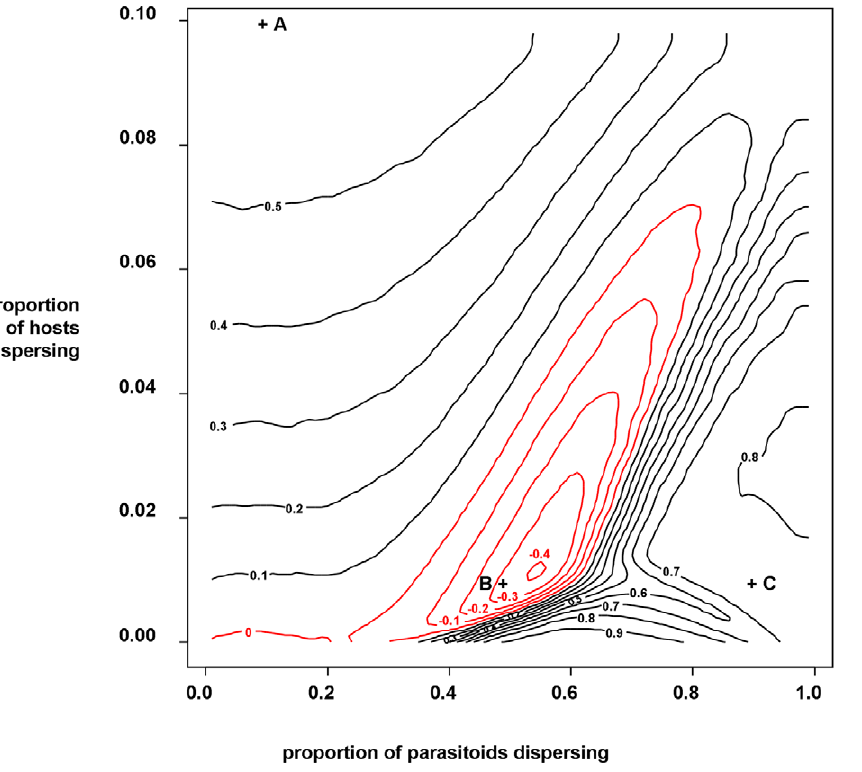
Figure 4. Predicted spatial correlations in local host abundances between habitat patches, under a range of host and parasitoid dispersal scenarios. The contours show common levels of correlation coefficient; black contours indicate positive correlation, red contours indicate negative correlation. Locations ( + ) labelled ‘a’ (10% host dispersal; 10% parasitoid dispersal), ‘b’ (1% host dispersal; 50% parasitoid dispersal) and ‘c’ (1% host dispersal; 90% parasitoid dispersal) relate to upper, middle and lower panels in figure 5